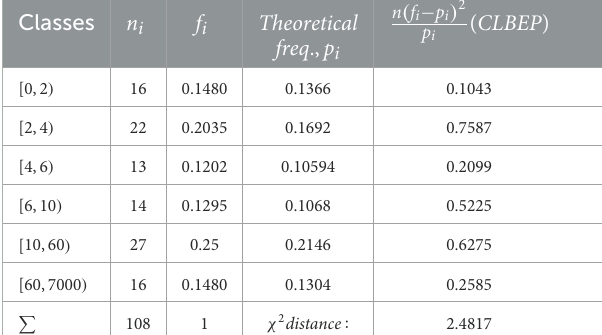
TABLE 4 Test for ˆ θ 3 = 4.9810.